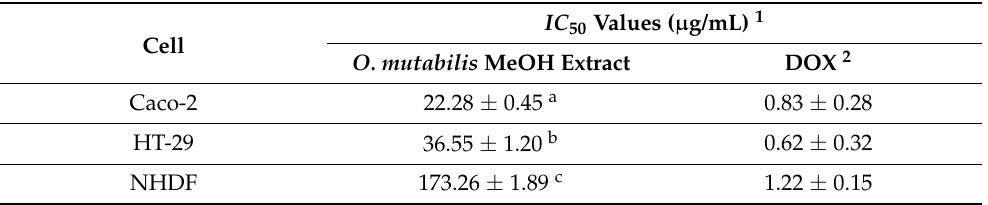
Table 1. Anticancer activity IC 50 ( µ g/mL) of O.mutabilis extract on Caco-2, HT-29, and L2OB after 24 h of